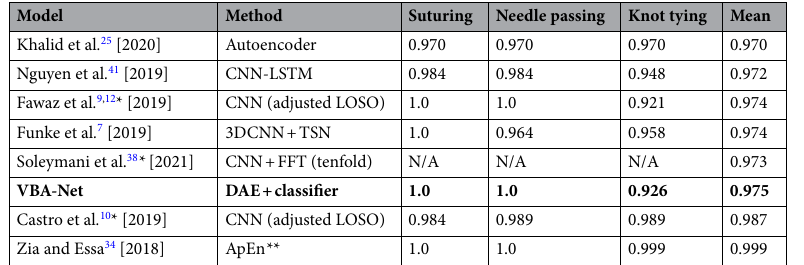
Table 3. Classification scores (> 0.97) for LOSO CV and other CV schemes. TSN temporal segment networks, FFT fast Fourier transform. *Taken from respective authors papers but were not included in the comparison. **Approximate Entropy. Significant values are in